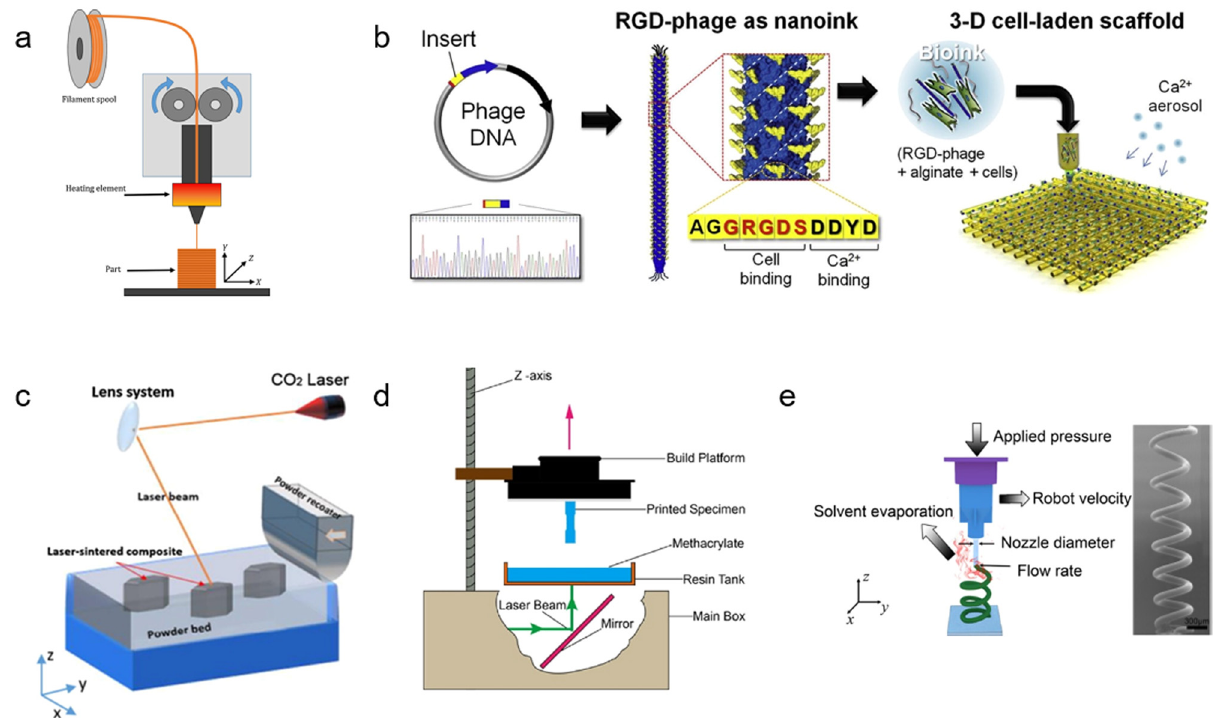
Figure 1: ( a ) Schematic of the working principle of FDM. Reproduced with permission from ref. [ 14 ] , Copyright 2016 Elsevier. ( b ) Schematic of the molecular design of the phages for use as a nanoink for 3D micro - extrusion bioprinting. Reproduced with permission from ref. [ 21 ] , Copyright 2016 Elsevier. ( c ) Illustrations of the SLS system. Reproduced with permission from ref. [ 23 ] , Copyright 2018 Elsevier. ( d ) Schematic of 3D SLA printing. Reproduced with permission from ref. [ 24 ] , Copyright 2017 Elsevier. ( e ) Schematic of the solvent - cast printing process and side view scanning electron microscopic ( SEM ) image of a circular spiral. Reproduced with permission from ref. [ 34 ] , Copyright 2014 American Chemical